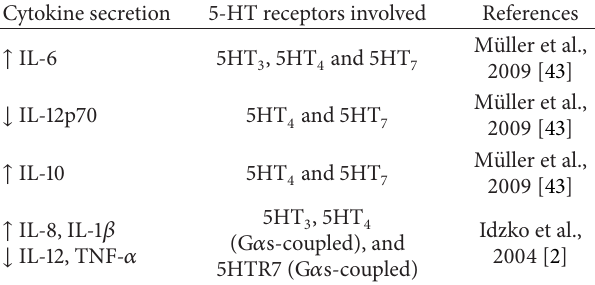
Table 2: The effect of 5-HT on MDDC cytokine